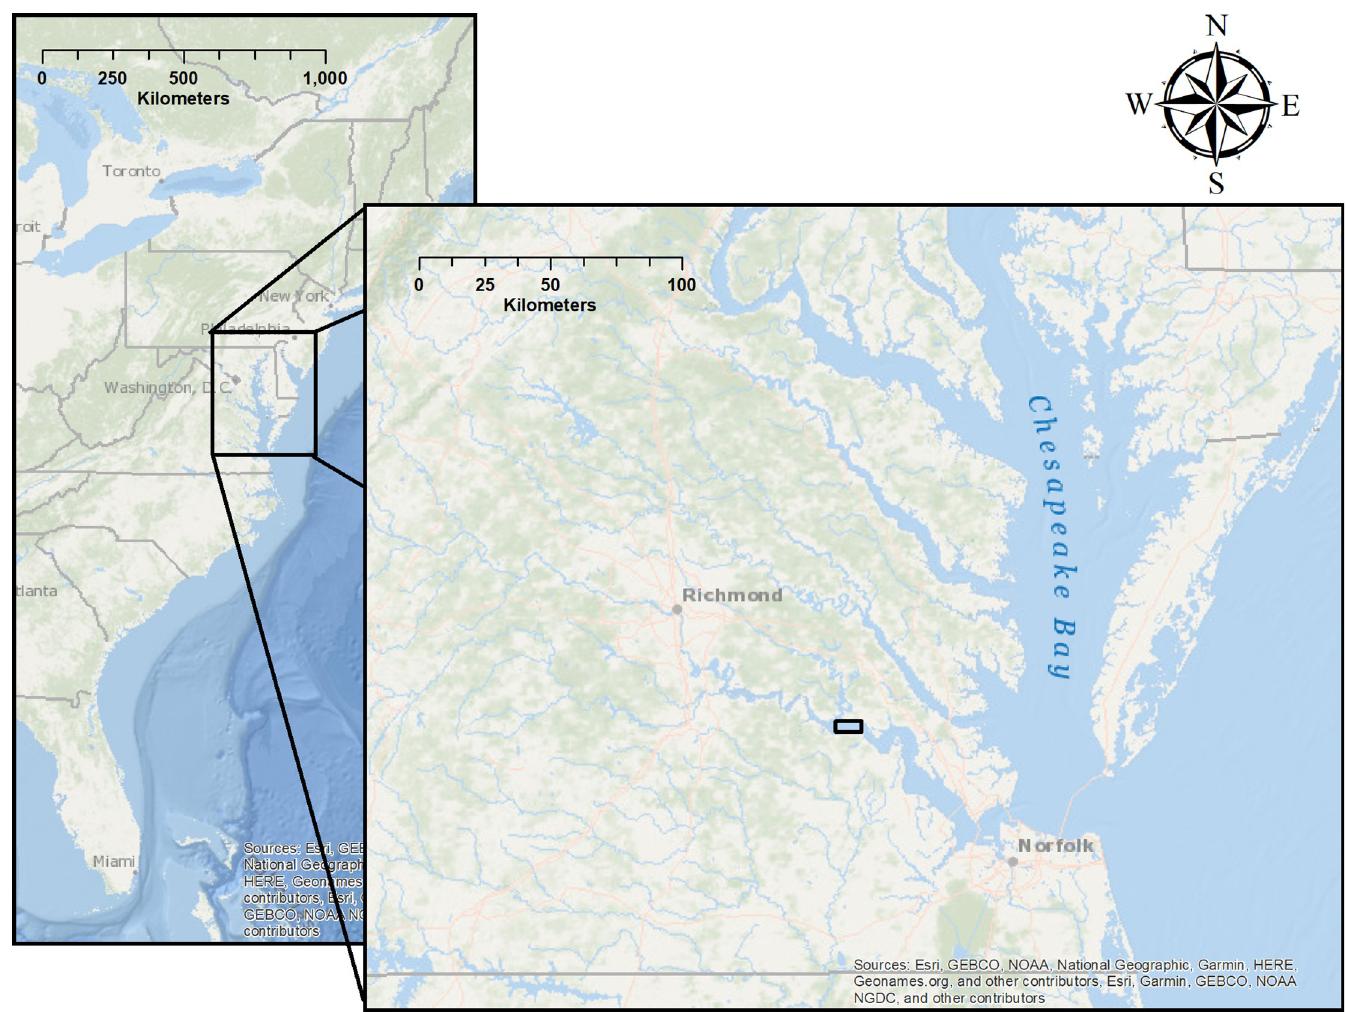
Fig 1. Map showing study location. Basemap reprinted from Ocean Basemap under a CC BY license, with permission from ESRI, original copyright 2012.